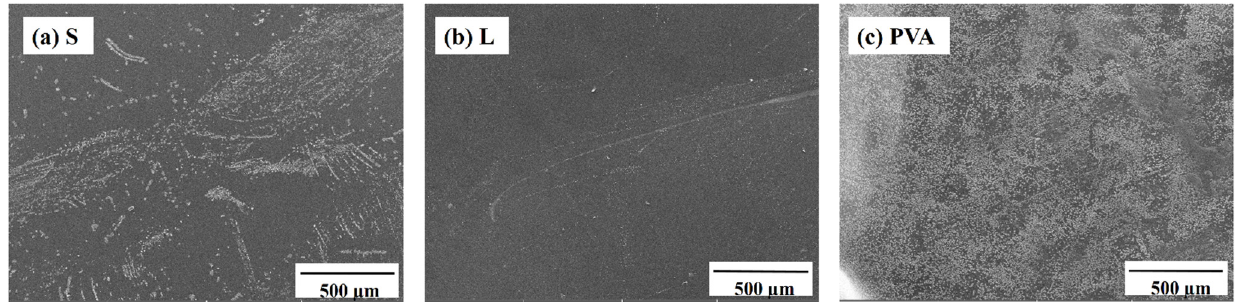
Figure 2. The surface morphology of the CHG film under the SEM.